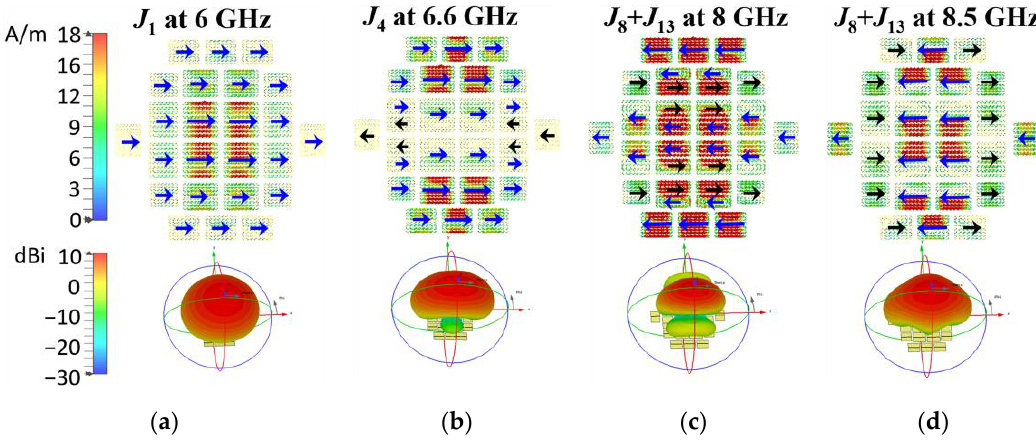
Figure 7. Modal currents J n ( ω ) and radiation patterns of the proposed metasurface (MTS3) at the resonant frequencies and at the upper frequency ends (8.0 and 8.5 GHz). ( a ) Mode 1 at 6 GHz, ( b ) Mode 4 at 6.6 GHz, ( c ) Mode 8 + 13 at 8.0 GHz, and ( d ) Mode 8 + 13 at 8.5 GHz.